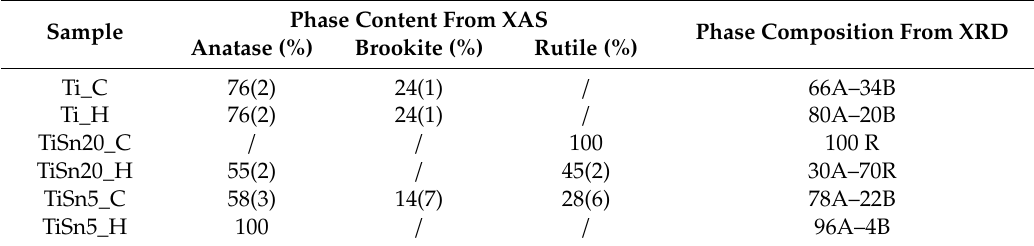
Table 1. Anatase, brookite, and rutile content (expressed as percentage) and associated error (in brackets) in the Sn-promoted TiO 2 samples derived from the linear combination fit of Ti K-edge XAS spectra. Phase composition (A: anatase, B: brookite, R: rutile) determined by X-ray di ff raction (XRD) is also reported for the sake of comparison from Ref.